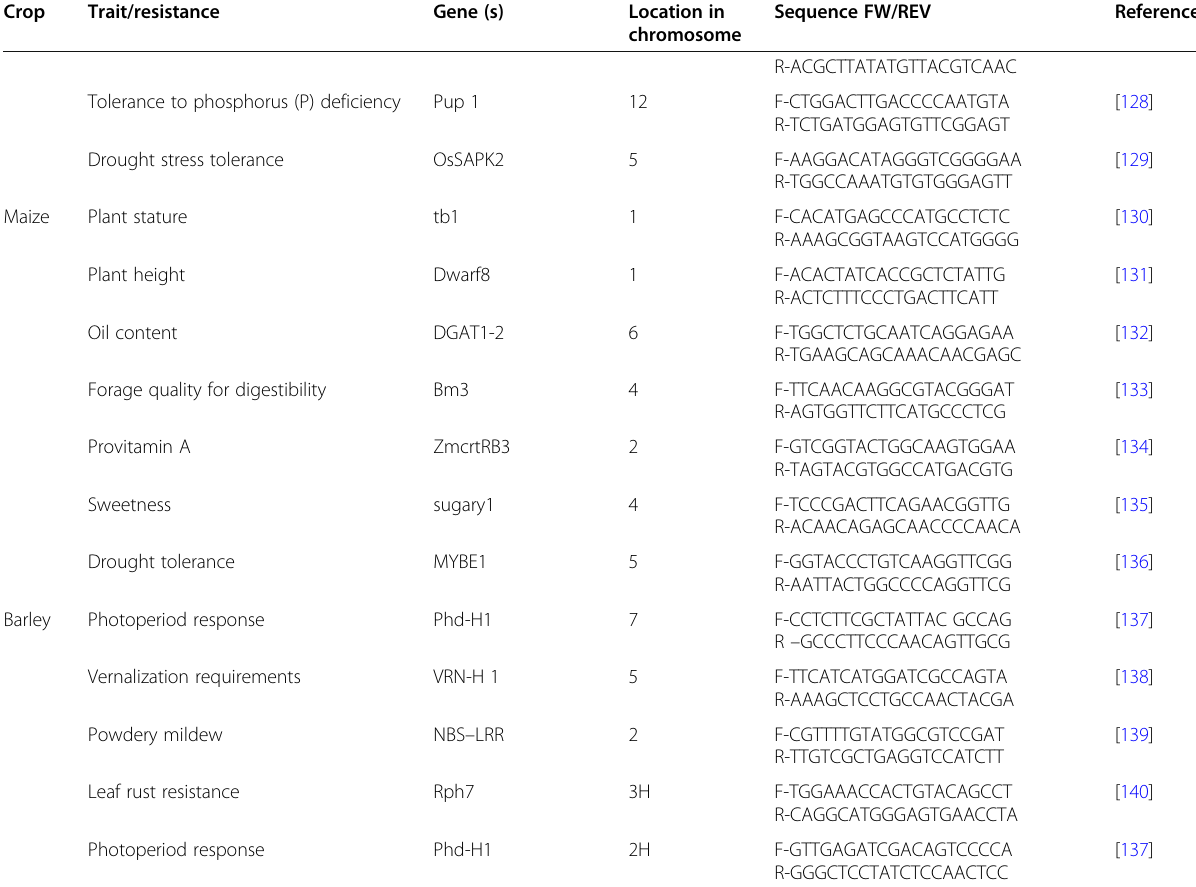
Table 5 Candidate genes for functional marker development (Continued) Crop